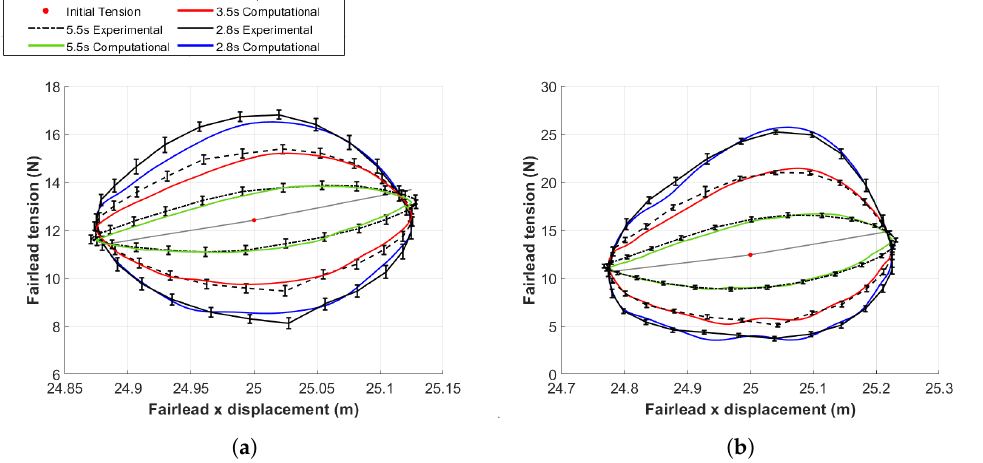
Figure 24. Comparison between the computed fairlead tension values and the experimental measure- ments of the mooring line with the clumped weight in configuration 2 for two different oscillation amplitudes A = 0.125, 0.225 m and three different periods T = 2.8, 3.5, 5.5 s for the isolated mooring line. ( a ) A = 0.125 m. ( b ) A = 0.225